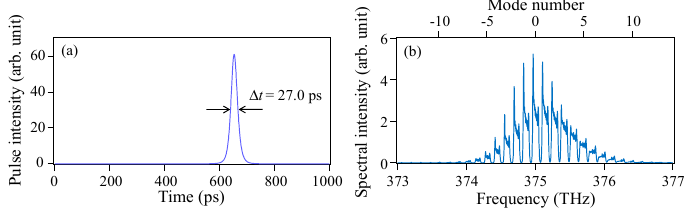
Figure 2. Simulated ( a ) temporal waveform averaged over 1000 single-shot pulses and ( b ) the corresponding power spectrum of the gain-switched pulse when the Langevin noise terms in Equations (1) and (2) are omitted ( ξ Sn = ξ Nn = 0).